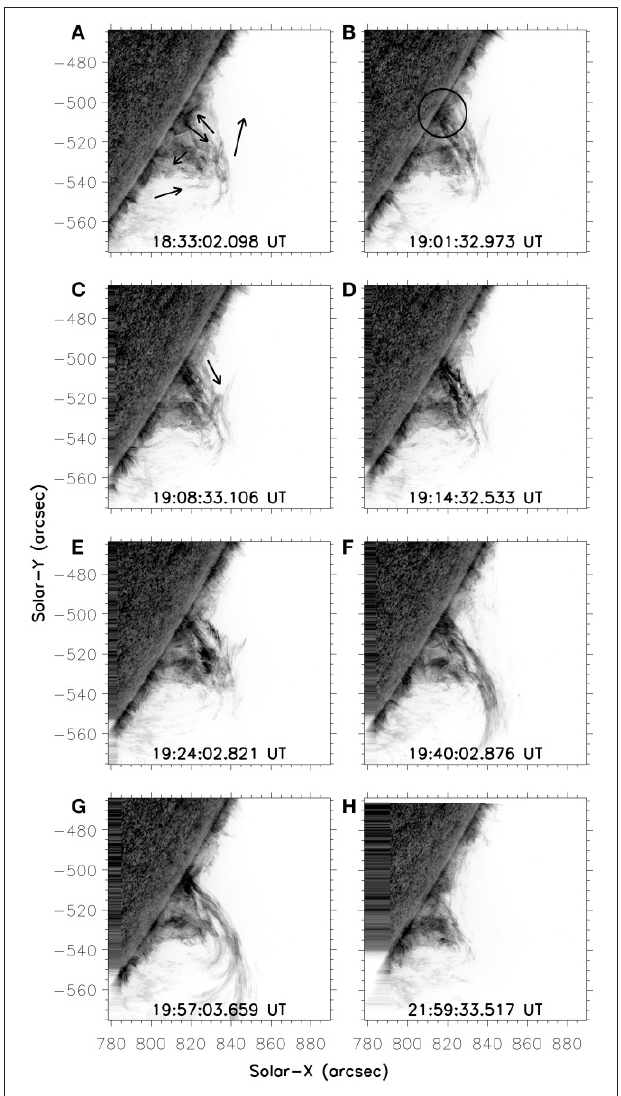
FIGURE 7 | Hinode SOT Ca II H-line observations (inverse intensity) of the prominence during the eruption. Panels (A,B) shows the prominence prior to the eruption with the arrows (A) indicating plasma motions and the base of the eruption is circled in (B) . Panels (C–E) show the initial phase of the eruption. The arrow points in the direction of the eruption. Panels (F,G) show the trajectory of the eruption and Panel (H) shows the prominence after the